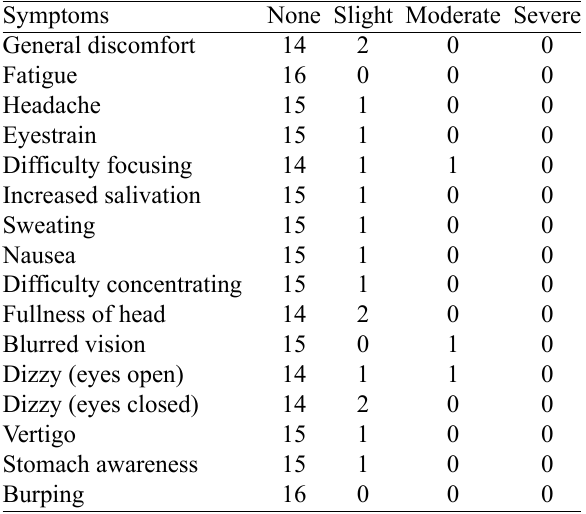
Table 2. Results of the SSQ questionnaire. Total of participants who reported symptoms after the experiment using the “Balance